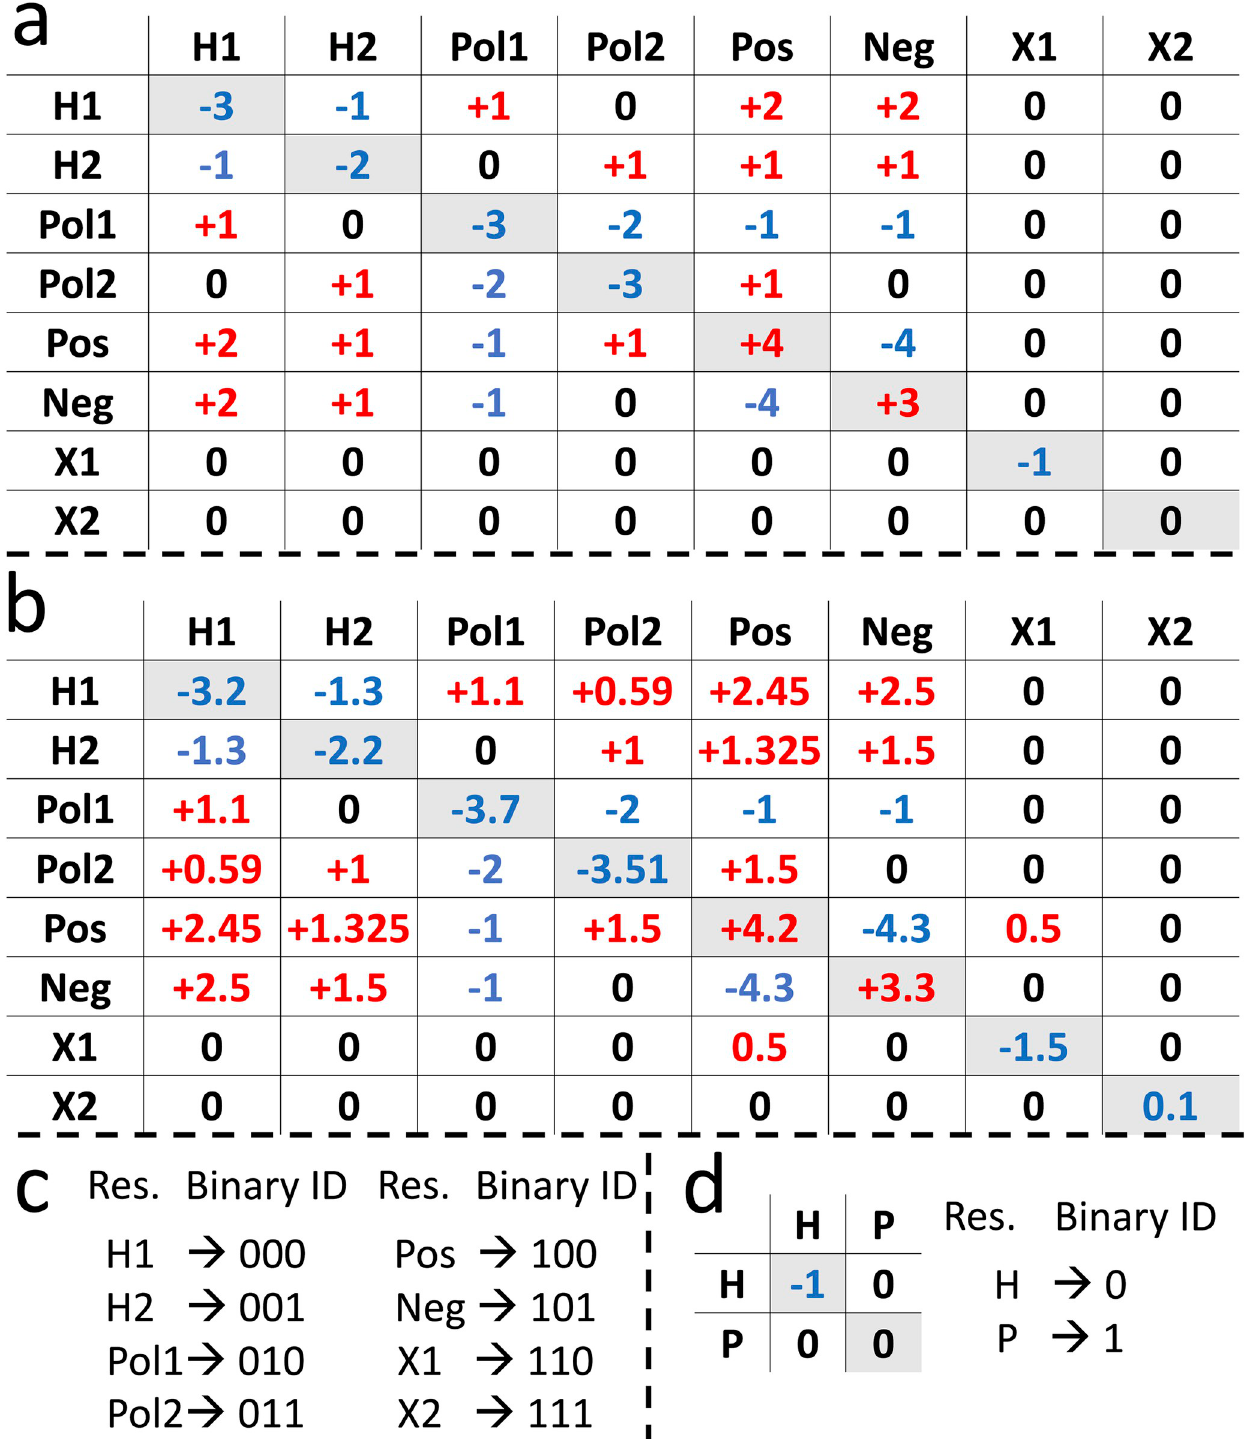
Fig 3. Energy tables to represent the pair-wise interactions in our systems and the binary representation of residues. Energy tables for: a) The SP model; b) The MR model. c) Binary representation of residues in the energy table. d) Energy table and the residue representations for the HP protein model. In a–c) H1 and H2 represent two types of hydrophobic residues, Pol1 and Pol2 represent two types of polar residues, Pos represents a positive residue, Neg represents a negative residue, and two types of “other” residues that do not fit in any of the previous categories are represented by X1 and X2 . Note that all energies in our tables have qualitative values. In d) H represents hydrophobic and P represents polar